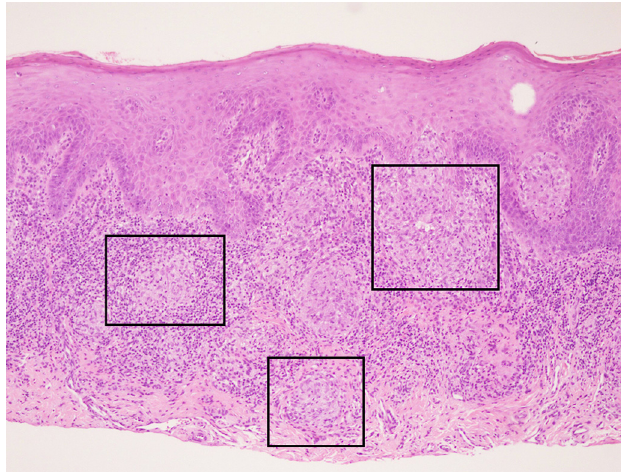
Fig. 2. Histological section of lower lip lesion. On medium power, tight granulomata are noted against a diffusely lymphocytic back- ground; hematoxylin-eosin, 100 (cid:1) .